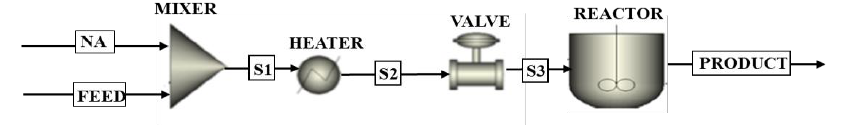
Figure 5. The flowsheet of fluidized-bed plant in ASPEN Plus ® .